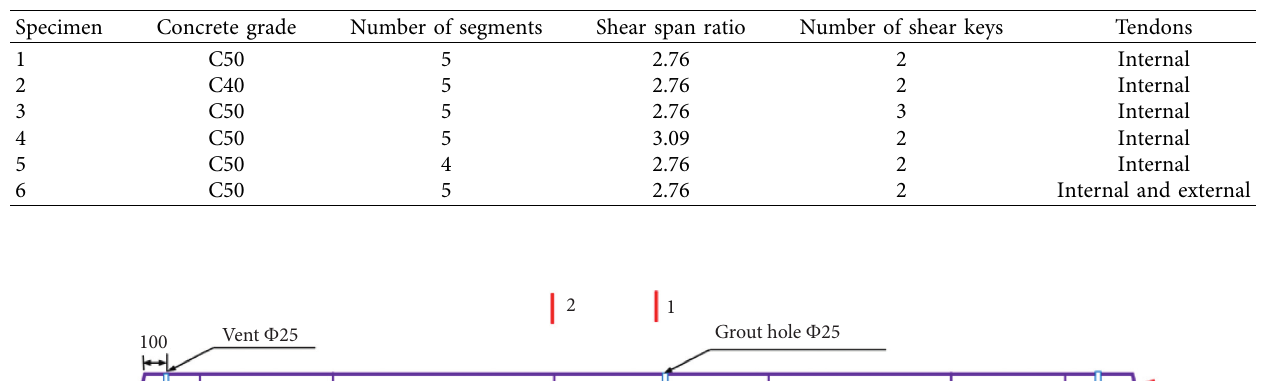
Table 1: Characteristics of